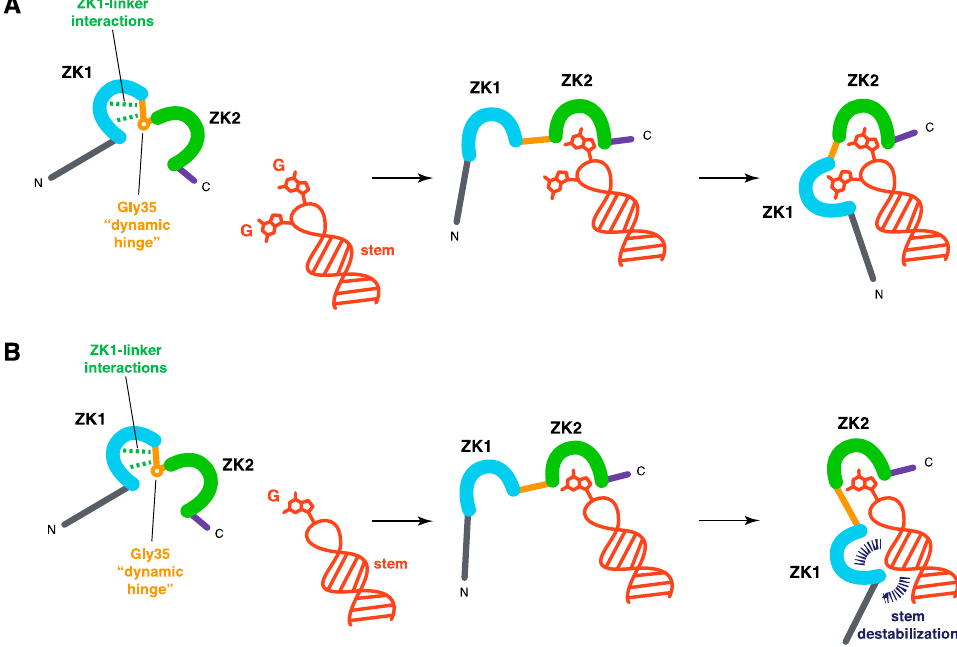
Figure 4. Schematic representation of the task specialization of each ZK upon binding to NA. The NA fragment is in red, NC ZKs are in cyan (ZK1) and green (ZK2), NC Nter and Cter tails are in grey and purple, respectively, and the inter-ZK linker is in orange. In the NA-free form of NC, interactions between the more rigid part of the linker and ZK1 are represented with dashed lines in green. In addition, within the linker, the Gly35 dynamic hinge is shown (see paragraph 3.2 and Figure 3). This dynamic hinge is not retained in NA-bound forms of NC, Gly35 being directly involved in the guanine recognition within ZK2 (see Figure 2C). ( A ) Situation 1, with two accessible guanines. The ZK1-linker interactions render ZK1 less accessible than ZK2. Thus, ZK2 binds first to an accessible guanine, and ZK1 binds the remaining guanine. The stem is not destabilized. ( B ) Situation 2, with only one accessible guanine. Similarly, ZK2 binds first to the unique accessible guanine, and ZK1 remains free to contact the stem via its large hydrophobic platform. The stem is destabilized (in dark blue).